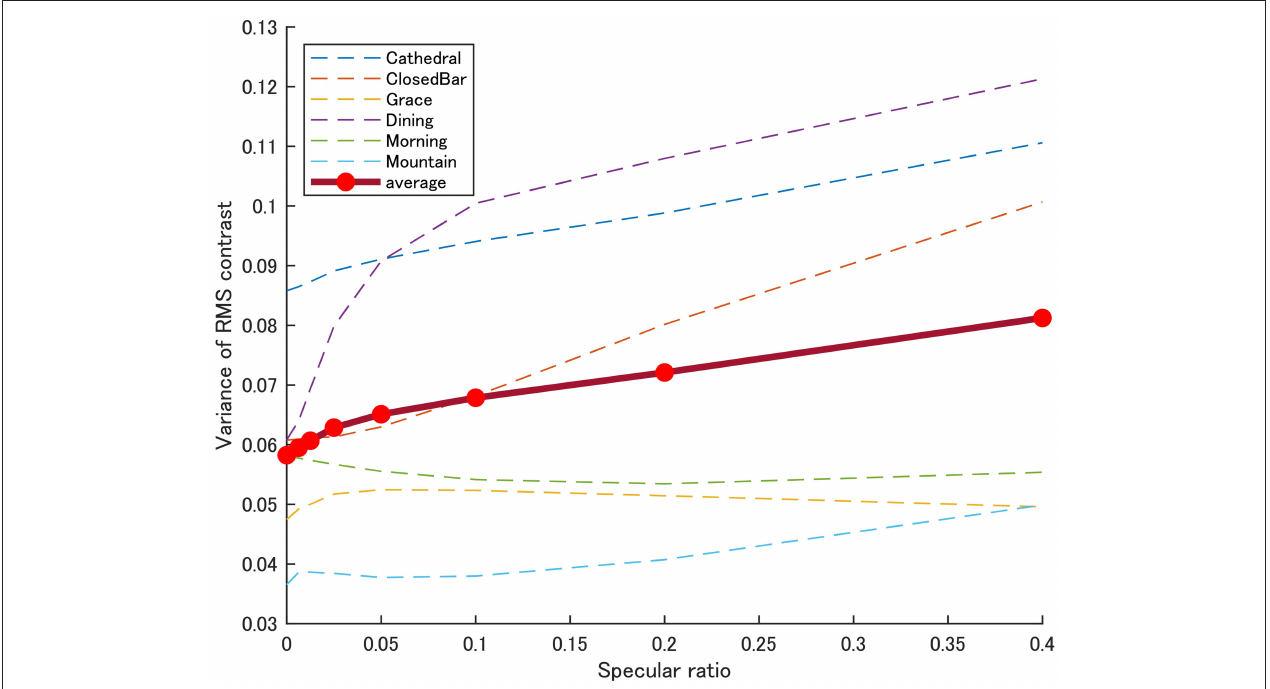
FIGURE 9 | Variance of local RMS contrast by specular ratio. Plots show the mean variance in local RMS contrast of Test objects in all six light probes as a function of specular ratio. The size of the region for calculating the variance of local RMS contrast was the same as used in Figure 5 .